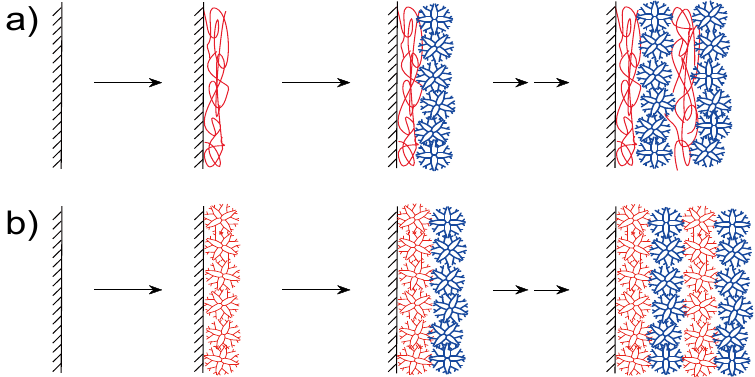
Figure 2. Preparation of ( a ) dendrimer/polymer and ( b ) dendrimer/dendrimer LbL